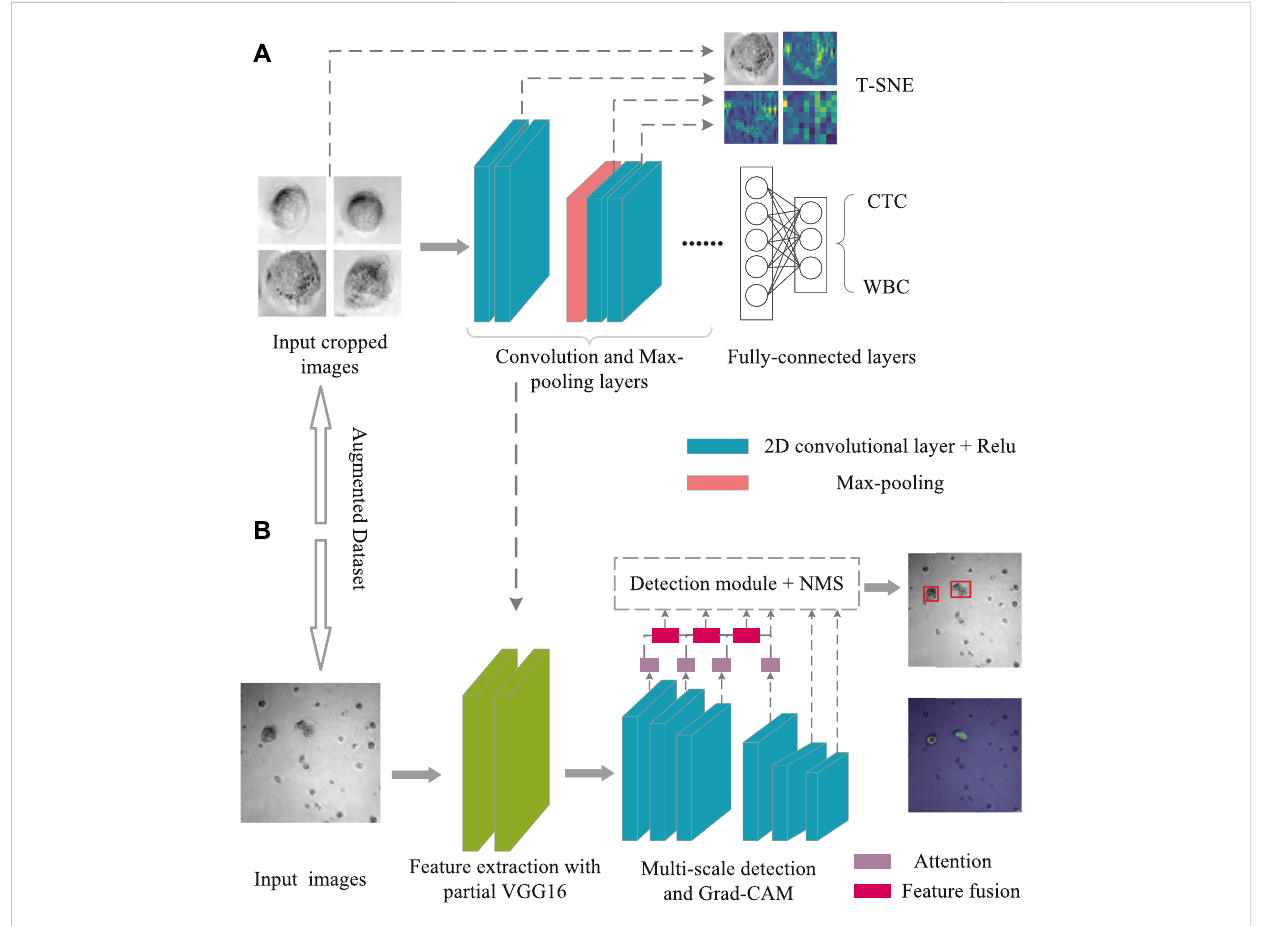
FIGURE 3 Schematic illustration of T-SNE for Dataset II treatment (A) and Grad-CAM for Dataset I analysis (B) .